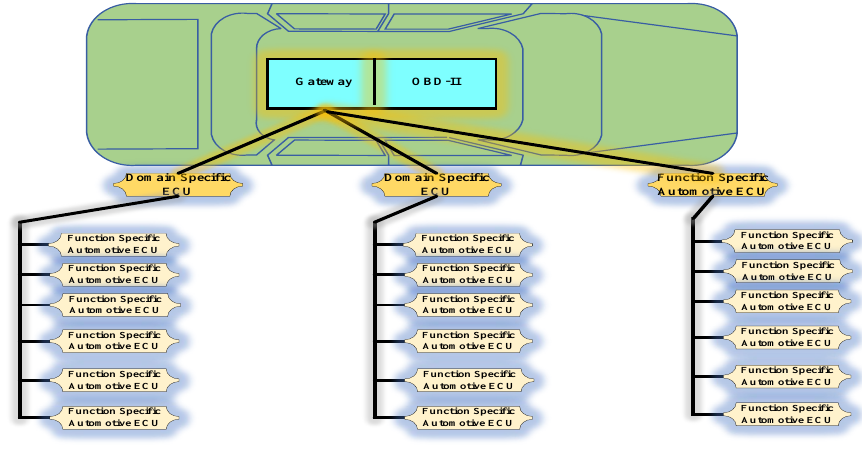
Figure 5. E/E Architecture-Domain Centralized.